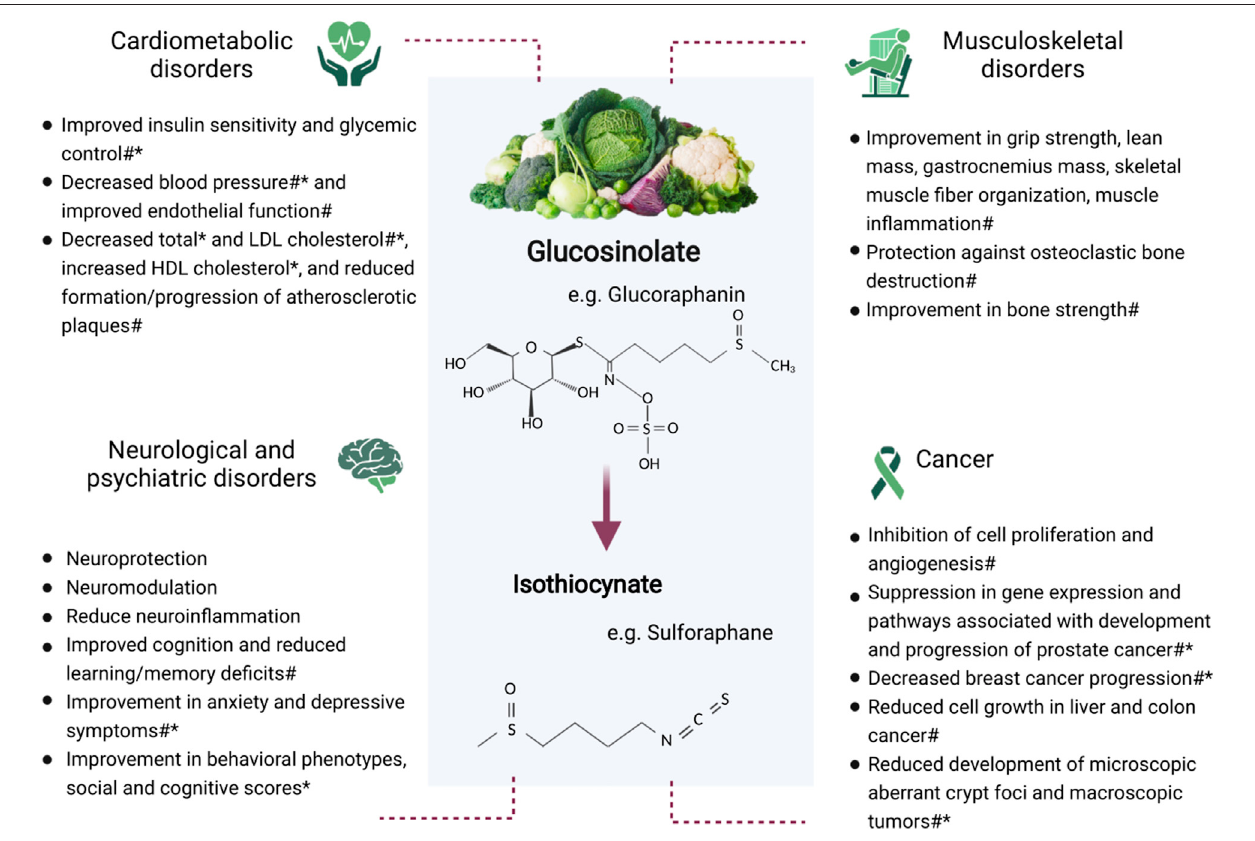
FIGURE 1 | Potential bene fi ts of glucosinolate consumption on cardiometabolic, neurological and psychiatric, and musculoskeletal conditions, and cancer. *Human study #Animal study.